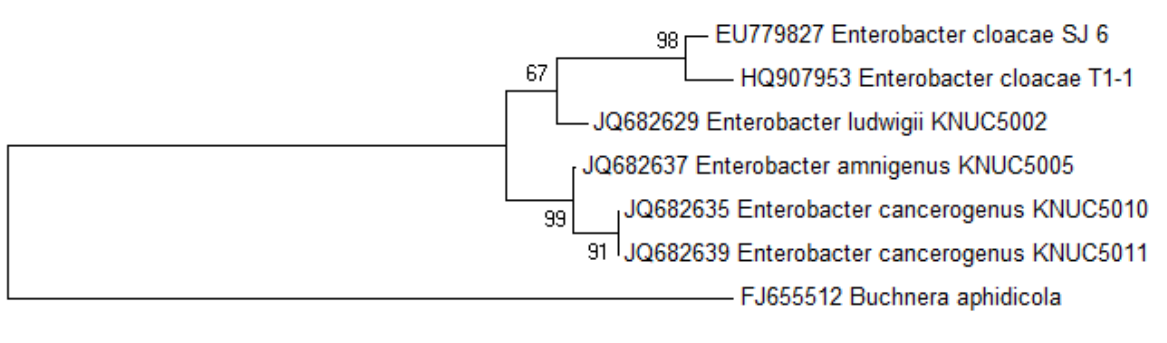
Figure 1. Phylogenetic analysis of oral bacterial isolate T1-1. 16S rDNA-based phylogenetic tree showing the phylogenetic position of isolate T1-1. The horizontal bar at the bottom represents evolutionary distance as number of changes per nucleotide